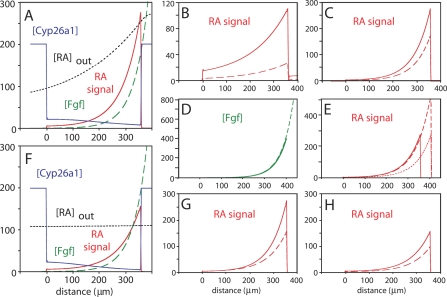
Modeling the RA Morphogen GradientA one-dimensional mathematical model of the gastrula-stage zebrafish embryo was developed that incorporates RA synthesis, diffusion, cell permeation, degradation, and signaling; a stable Fgf gradient; and expression of cyp26a1 under the control of RA and Fgf signaling, as well as other position-specific cues (see Materials and Methods). In each panel, anterior is to the left and posterior to the right. On the abscissa, zero represents the posterior boundary of the domain of high, anterior cyp26a1 expression (approximately the r1/r2 border), which is set independently of RA. Values on the ordinate are in arbitrary units. Fgf concentration is shown in green, Cyp26a1 in blue, extracellular RA ([RA]out) in black, and RA signaling (a function of intracellular RA) is shown in red. Parameter values common to all panels are given in Materials and Methods.(A) Typical patterns of RA signaling and cyp26a1 expression generated by the model. Note the presence of low-level cyp26a1 expression that declines from anterior to posterior.(B and C) Feedback and feedforward regulation of cyp26a1 expression leads to robustness to RA synthesis rates. In both panels, the dashed curves show the effects of a 2-fold decrease in RA production. In (B), cyp26a1 is taken to be constant over the interval 0 < x < 360 μm, whereas in (C), it is regulated as prescribed by the model. Note the dramatic increase in robustness in (C).(D and E) Effect of embryo elongation on Fgf and RA gradients. In both panels, solid lines are calculated for a posterior margin at 400 μm; dashed lines for a posterior margin at 450 μm. In (D), the dashed line is calculated using a rate of Fgf synthesis 2.75 times higher than for the solid line; this is to the degree of increase that would be required to compensate for the rearward movement of the Fgf source. (E) shows that, using the same sets of parameters, the RA gradient automatically compensates for the rearward movement of the RA source, without any need for readjustment of RA synthesis. For comparison, the dotted line shows what would happen to the RA gradient were there no such compensation.(F and G) RA supplied in a completely delocalized manner can produce a relatively normal morphogen gradient. (F) is a modification of (A), in which the endogenous posterior source of RA (from 360 < x < 400) has replaced by a constant influx of RA at all locations. For an appropriate rate of exogenous RA influx, relatively normal patterns of RA signaling and cyp26a1 expression ensue, despite the lack of an extracellular RA gradient. This is particularly true at anterior locations, as shown in (G), in which the RA signaling gradients from (A) and (F) are compared (solid and dashed curves, respectively).(H) RA signaling gradients produced by delocalized RA are robust to rates of RA influx. Like gradients produced by endogenous RA (C), gradients produced by exogenous, delocalized RA are also predicted to be robust (solid curve is RA signaling from [F]; dashed curve shows the effect of a 2-fold decrease the in the rate of RA influx). Values of parameters that differed between panels were β = 1 ([A–E] and solid curve in [G]) or 0.5 ([F], [H], and dashed curve in [G]); x
f = 400 μm ([A–C] and [F–H]) or 450 μm (D–E); f
0 = 0 (B), 400 ([A], [C], [F–H], and solid curves in [D] and [E]), or 1,100 (dashed curves in [D] and [E]); k
deg = 500 sec−1 ([A] and [C–G]) or 0.03 sec−1 (B); k
max = 0.001 ([A] and [C–G]) or 4 (B); V(x) = 5 for x > x
f – 40, zero otherwise ([A], [D], [E], and solid curves in [B], [C], and [G]), 2.5 for x > x
f – 40, zero otherwise (dashed curves in [B] and [C]), 0.2 for all x ([F], dashed curve in [G], and solid curve in [H]), or 0.1 for all x (dashed curve in [H]).